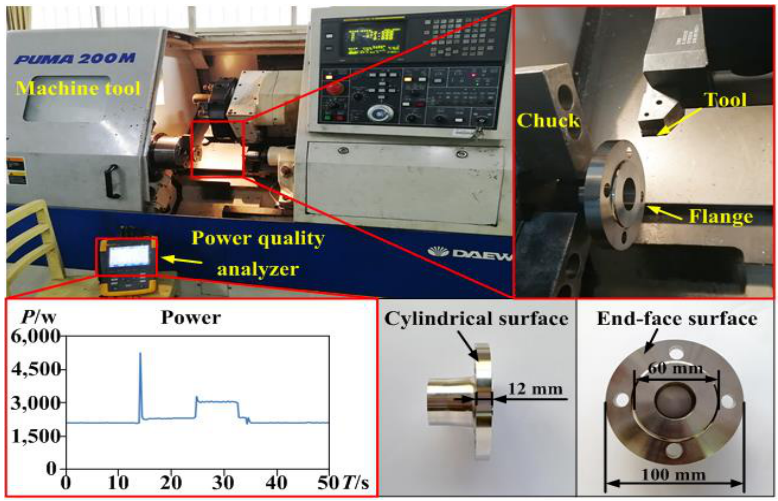
Figure 1. Processing and measuring equipment.